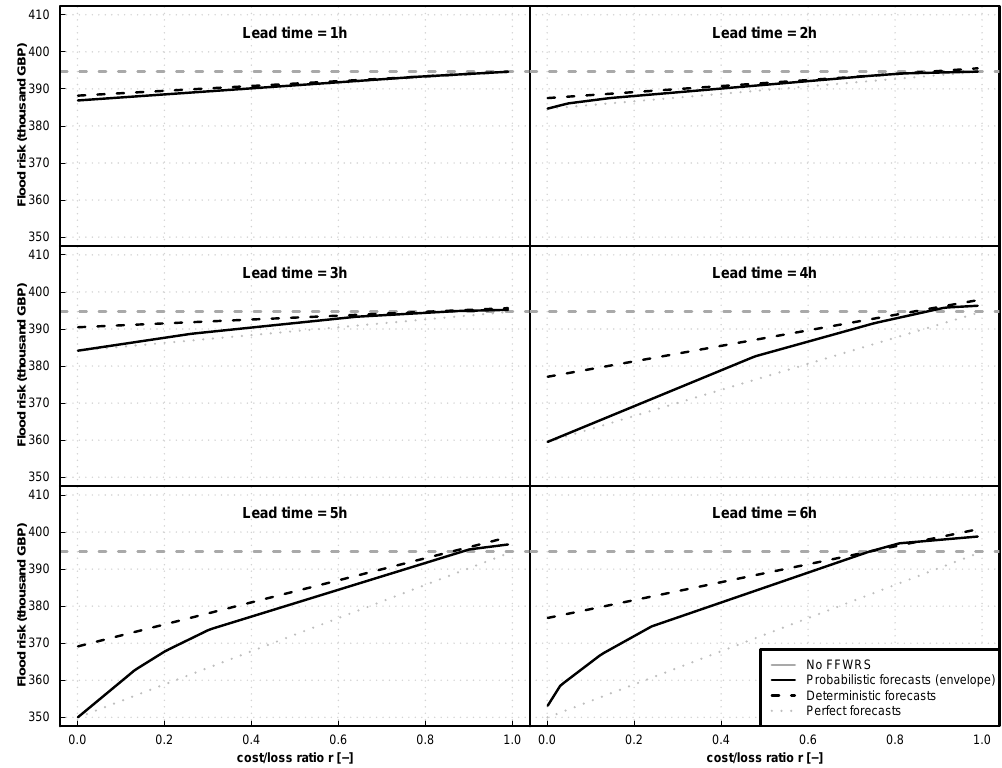
Fig. 10. Flood risk as a function of cost-loss ratio, for all lead-times and all cases.